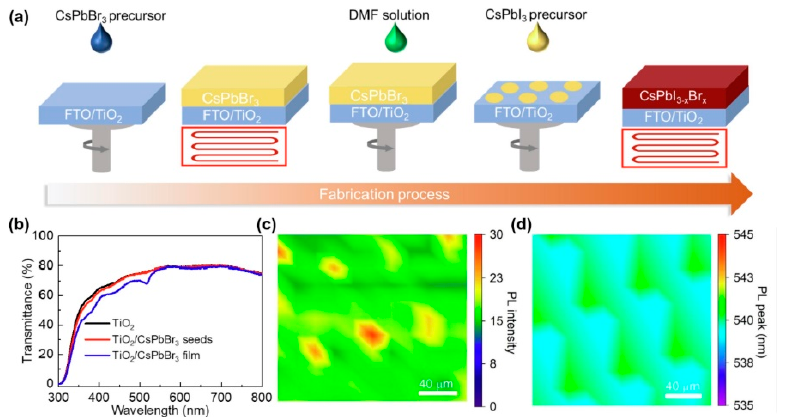
Figure 3. ( a ) Schematic of preparation process of CsPbI 3 films with CsPbBr 3 pieces. ( b ) Transmittance spectra of TiO 2 , TiO 2 /CsPbBr 3 seeds, and TiO 2 /CsPbBr 3 film. ( c ) Confocal PL intensity and ( d ) PL peak position maps of TiO 2 /CsPbBr 3 pieces, respectively reprinted with permission from Ref. [126] 2023 Elsevier.